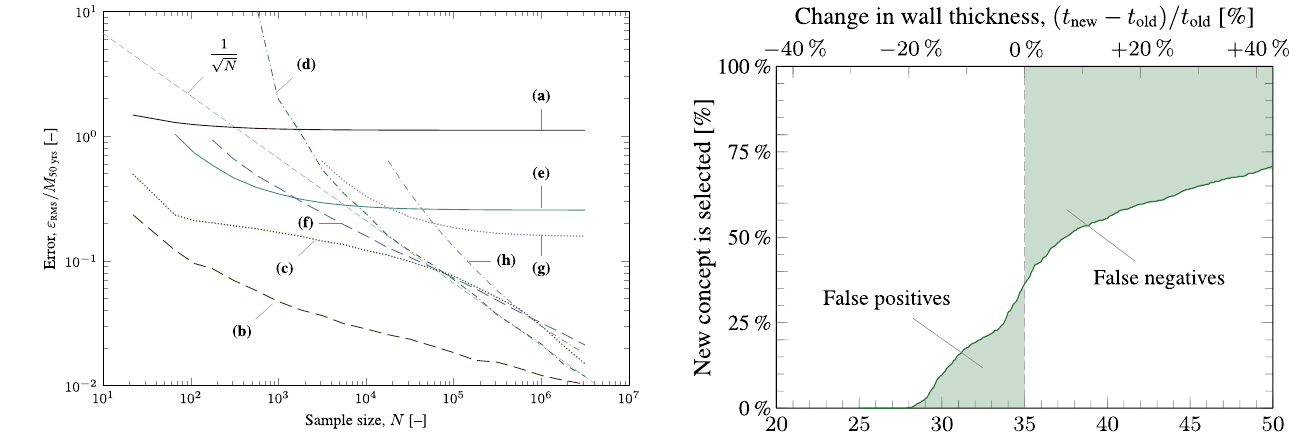
Figure 9. Root-mean-squared error in the extrapolated 50-year overturning moment, as a function of sample size.